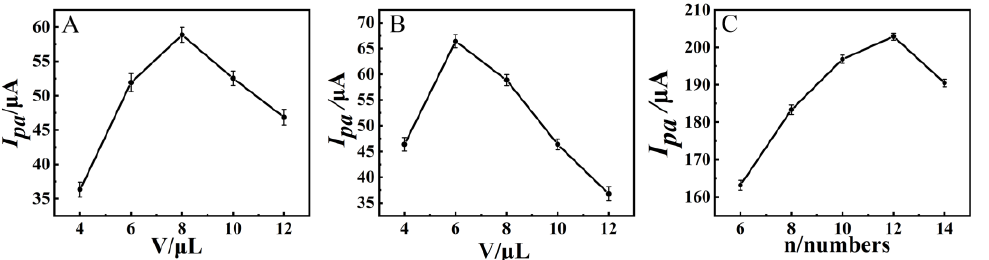
Figure 8. ( A ) Effect of Zn/Fe-ZIF-NPC loading volume on I pa of NiHCF-NPs/Zn/Fe-ZIF-NPC/GCE, ( B ) Effect of NiHCF-NPs loading volume on I pa of NiHCF-NPs/Zn/Fe-ZIF-NPC/GCE, ( C ) Effect of CV cycle numbers of AuNPs electrodeposition on the I pa of AuNPs/NiHCF-NPs/Zn/Fe-ZIF- NPC/GCE. Error bars were obtained as the standard deviation of triple measurements ( n = 3).